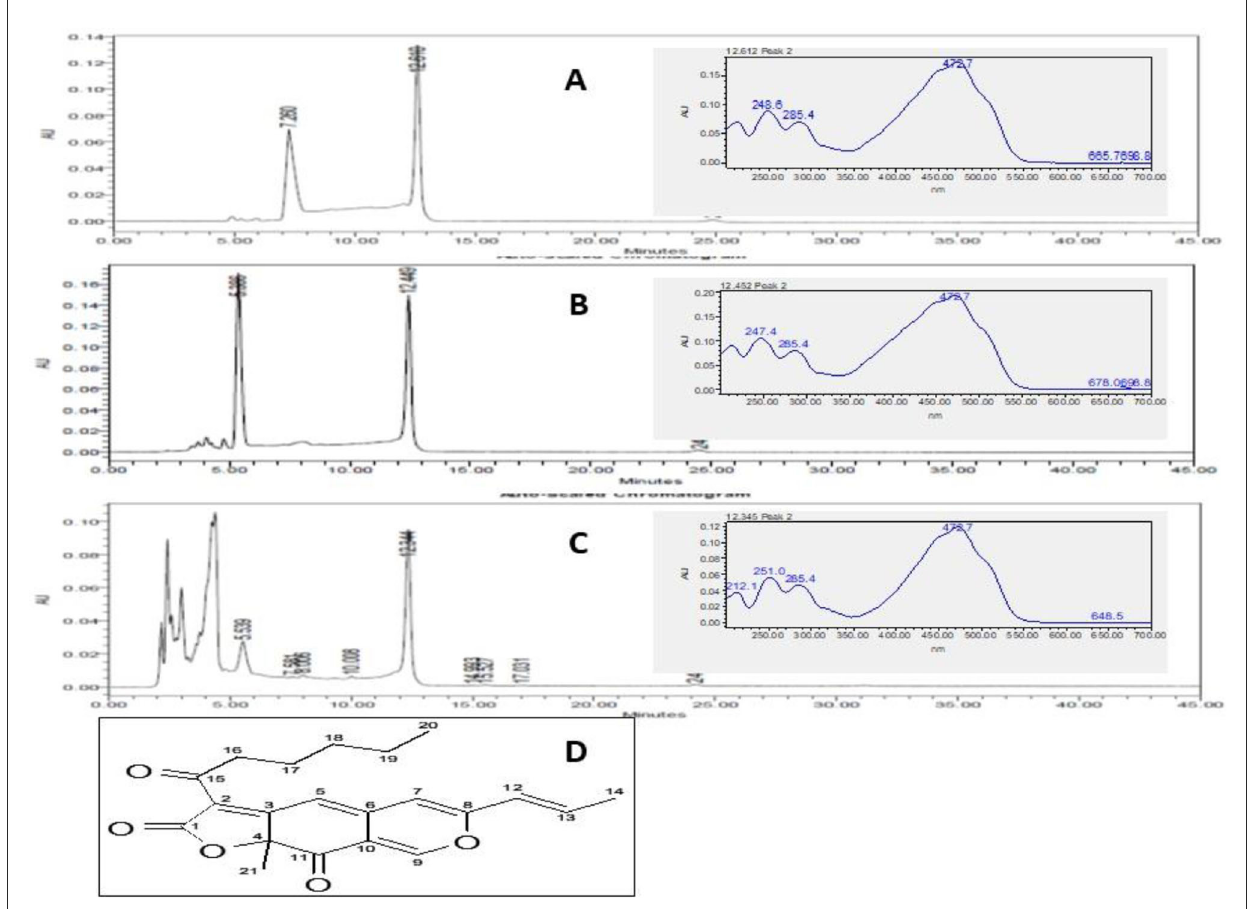
FIGURE4 HPLC chromatograph of M. purpureus pigment extracted in hexane (A) , ethyl acetate (B) , and ethanol (C) showing elution of the pigment fractions. The peak at 12min was observed in all the extracts. The inset picture shows the UV–visible spectrum of the common major pigment fraction detected at 495nm. The UV–visible spectrum shows the peak at 248, 285, and 472nm corresponding to the rubropunctatin (Dhale et al., 2018) pigment molecule (D) .